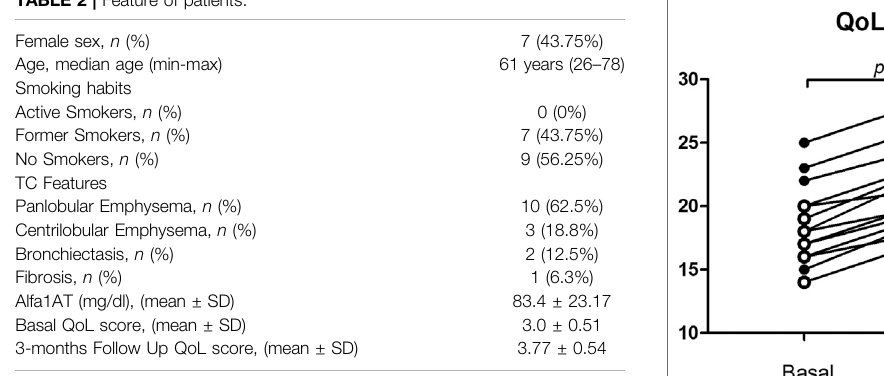
TABLE 2 | Feature of patients.